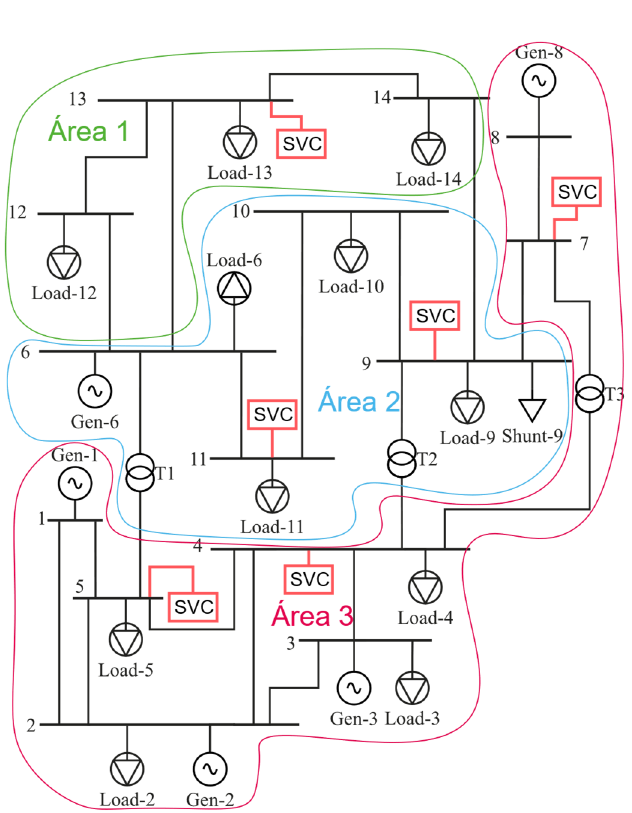
Figure 4. VCAs in the IEEE 14-bus test system.